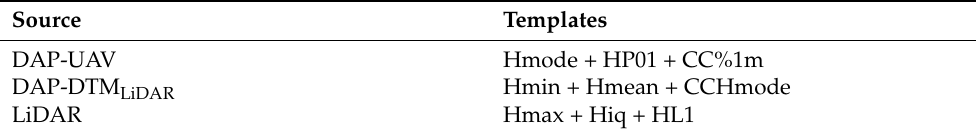
Table 12. Best models to estimate basal area from DAP-UAV, DAP-DTM LiDAR , and LiDAR.